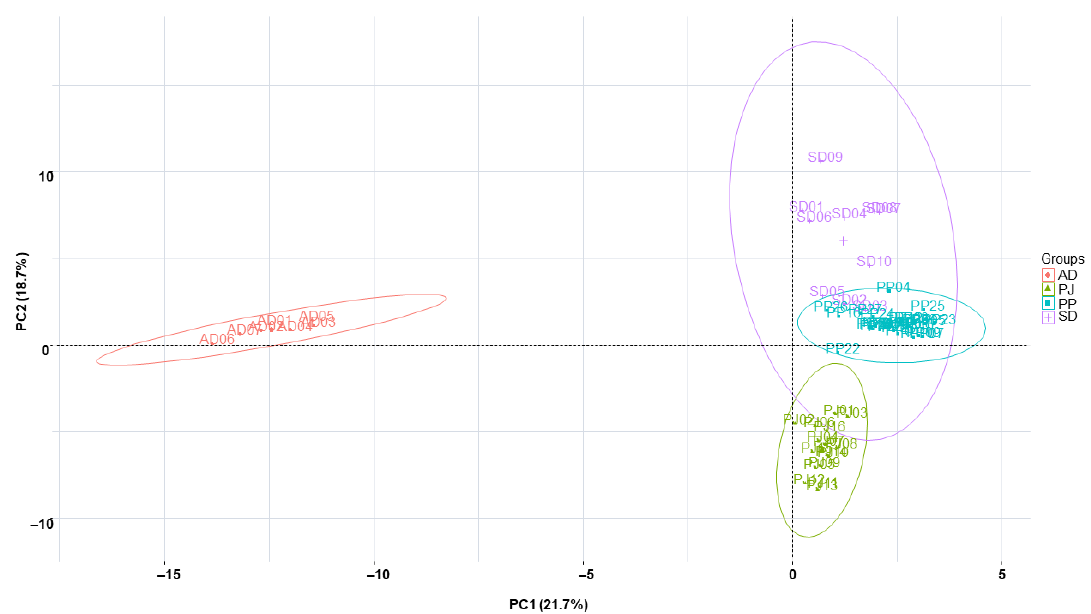
Figure 3. Score plot of principal components (PC1 vs. PC2) based on the variables (absolute area of reference peaks) with Peucedanum japonica , P. praeruptorum , Angelica decursiva , and Saposhnikovia divaricata samples based on a 99% confidence ellipse. PC1 and PC2 represent 21.7% and 18.7% of the total variance, respectively. PJ: Peucedanum japonicum , PP: P. praeruptorum , AD: Angelica decursiva , SD: Saposhnikovia divaricata.